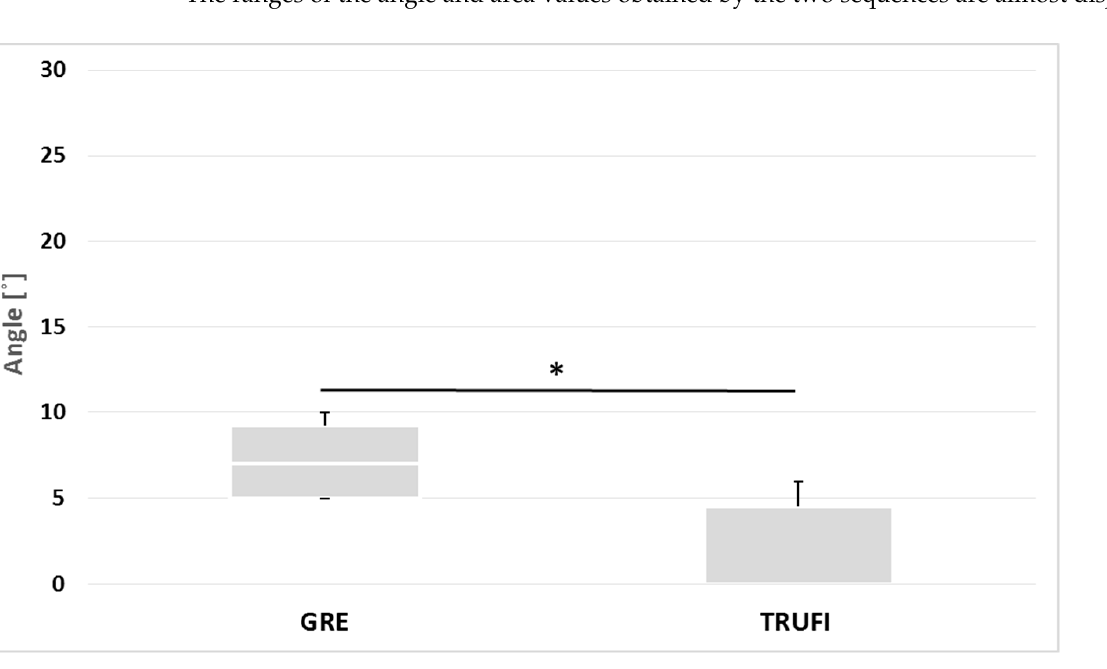
Figure 8. The values of the maximum glottic angles of the paralyzed vocal fold during phonation in MRI dynamic sequences. * p = 0.0136.